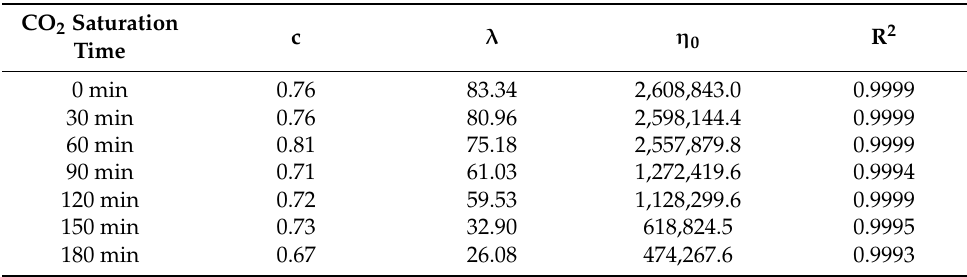
Table 2. Rheological parameters of pre-vulcanized silicone rubber samples being treated with different CO 2 saturation